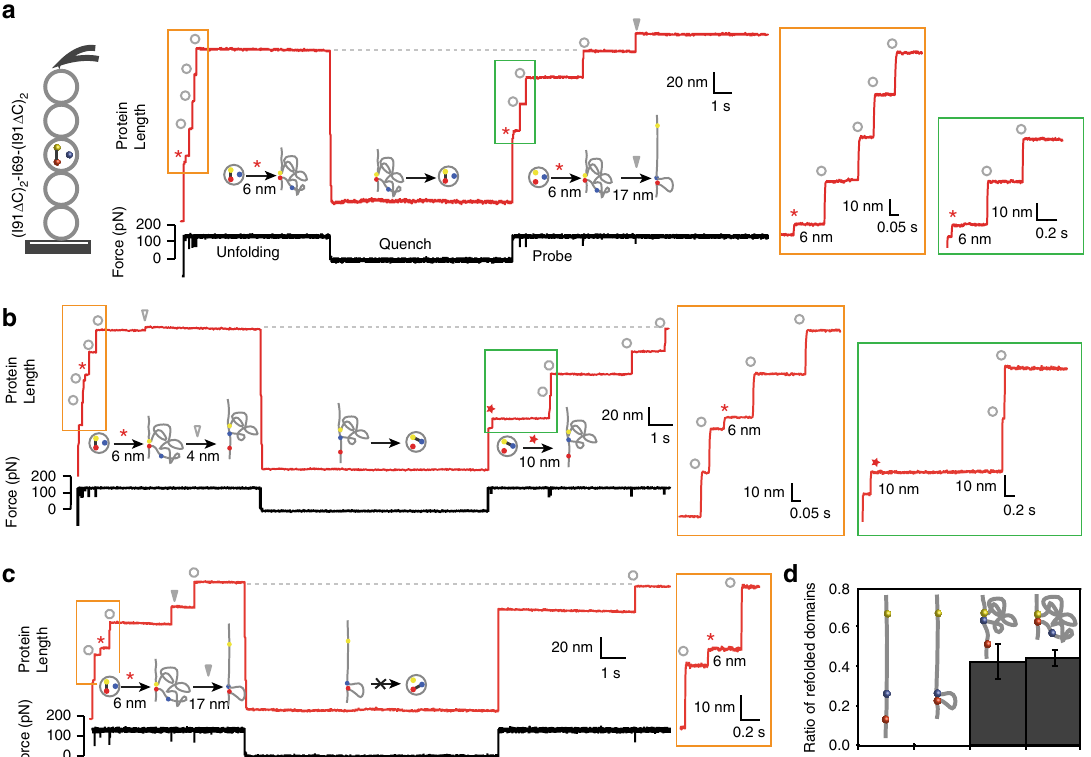
Fig. 5 Disul fi de bonds enable refolding of I69. a We use the engineered heteropolyprotein (I91 Δ Cys) 2 – I69-(I91 Δ Cys) 2 to characterize the in fl uence of disul fi de bonds on the refolding of I69 oxidized (quench Δ t = 10 s, unfolding/probe force = 130 pN). Only traces that show the same extension (doted gray lines) at the end of the unfolding and probe pulses (before isomerization steps in the probe pulse) are considered. This recording indicates that I69 oxidized unfolds in the unfolding pulse (6 nm step) and refolds during the quench while the disul fi de CysB – CysG remains formed (6 nm step in the probe pulse). In this example trace, a subsequent isomerization step is detected in the probe pulse (solid triangle). b In this trace, disul fi de CysB – CysF is formed through isomerization during the unfolding pulse (4 nm step, gray empty triangle). A 10 nm step in the probe indicates that I69 has refolded during the quench pulse keeping disul fi de CysB – CysF. c Alternatively, if CysF – CysG forms (17 nm step, gray fi lled triangle), the absence of 23 nm step in the probe suggests an inability to refold during the quench. d Histogram summarizing how the three possible disul fi de bonds formed within the triad affect the refolding probability of I69 oxidized for a quench time of 10 s, as determined with the protein (I91 Δ Cys) 2 -I69-(I91 Δ Cys) 2 . Data for I69 reduced were obtained with (I69) 8 . The refolding probability and associated SEM represented by the error bars were calculated by bootstrapping. N = 131 (CysB – CysG), N = 31 (CysB – CysF) and N = 38 (CysF –